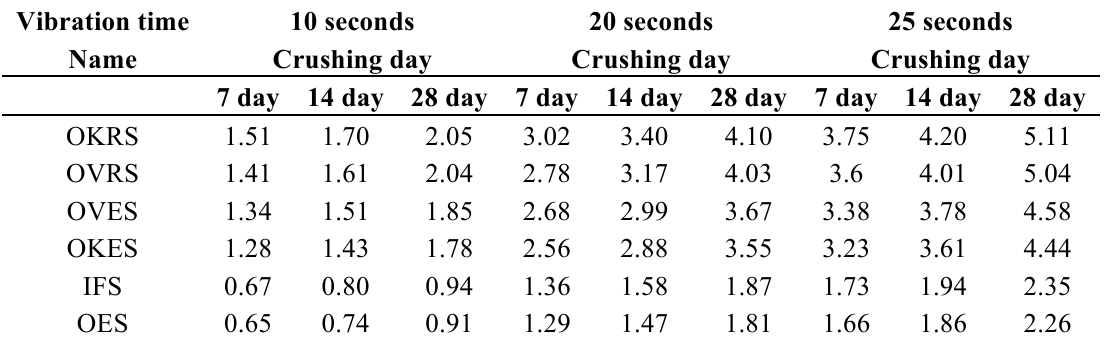
Table 7. Average compressive strength values for 150 mm sandcrete blocks at 10 seconds, 20 seconds and 25 seconds vibration time.